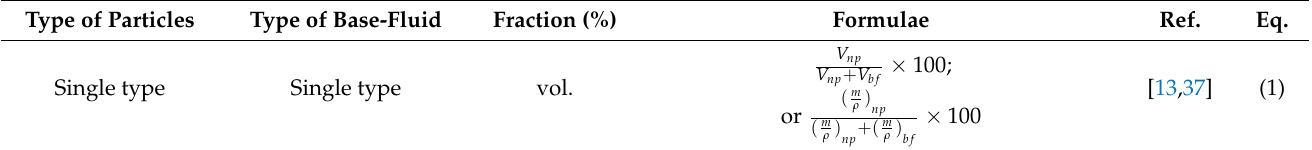
Table 1. Fraction calculation Formulae for different forms of nanofluids. Type of Particles Type of Base-Fluid Fraction (%) Formulae Ref. Single type Single